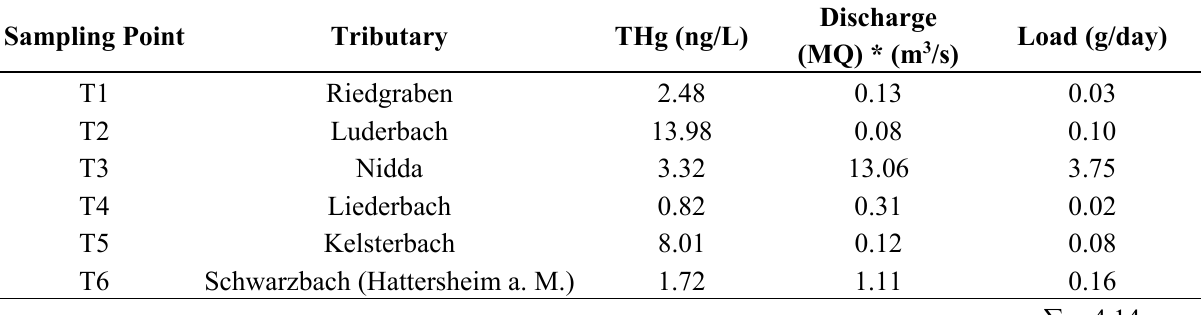
Table 2. THg concentration in samples from 6 tributaries (T1–T6) near the mouth into the river Main, arithmetic mean annual discharges at the mouth and calculated daily THg